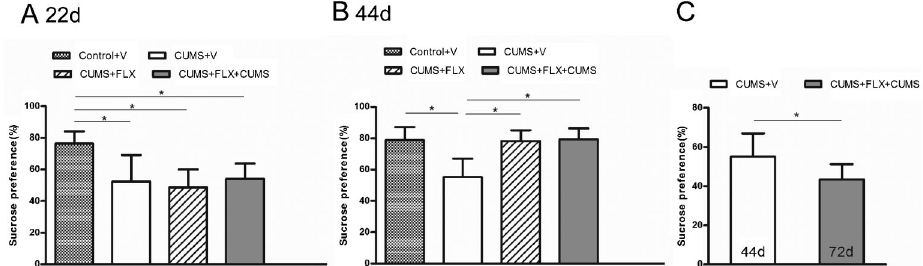
Figure 2. A , Effects of chronic unpredictable mild stress (CUMS) on sucrose preference in rats. Prior to each test, rats were water- deprived for 12 h. They were then exposed to both a 1% sucrose solution and tap water. B , Effects of fluoxetine (FLX) on sucrose preference in rats. C , Effects of re-exposure to CUMS on sucrose preference in rats. Data are reported as means±SD. *P , 0.01 ( Panels A and B ) and *P , 0.05 ( Panel C ) (one-way ANOVA followed by the Bonferroni test). V: vehicle; d: